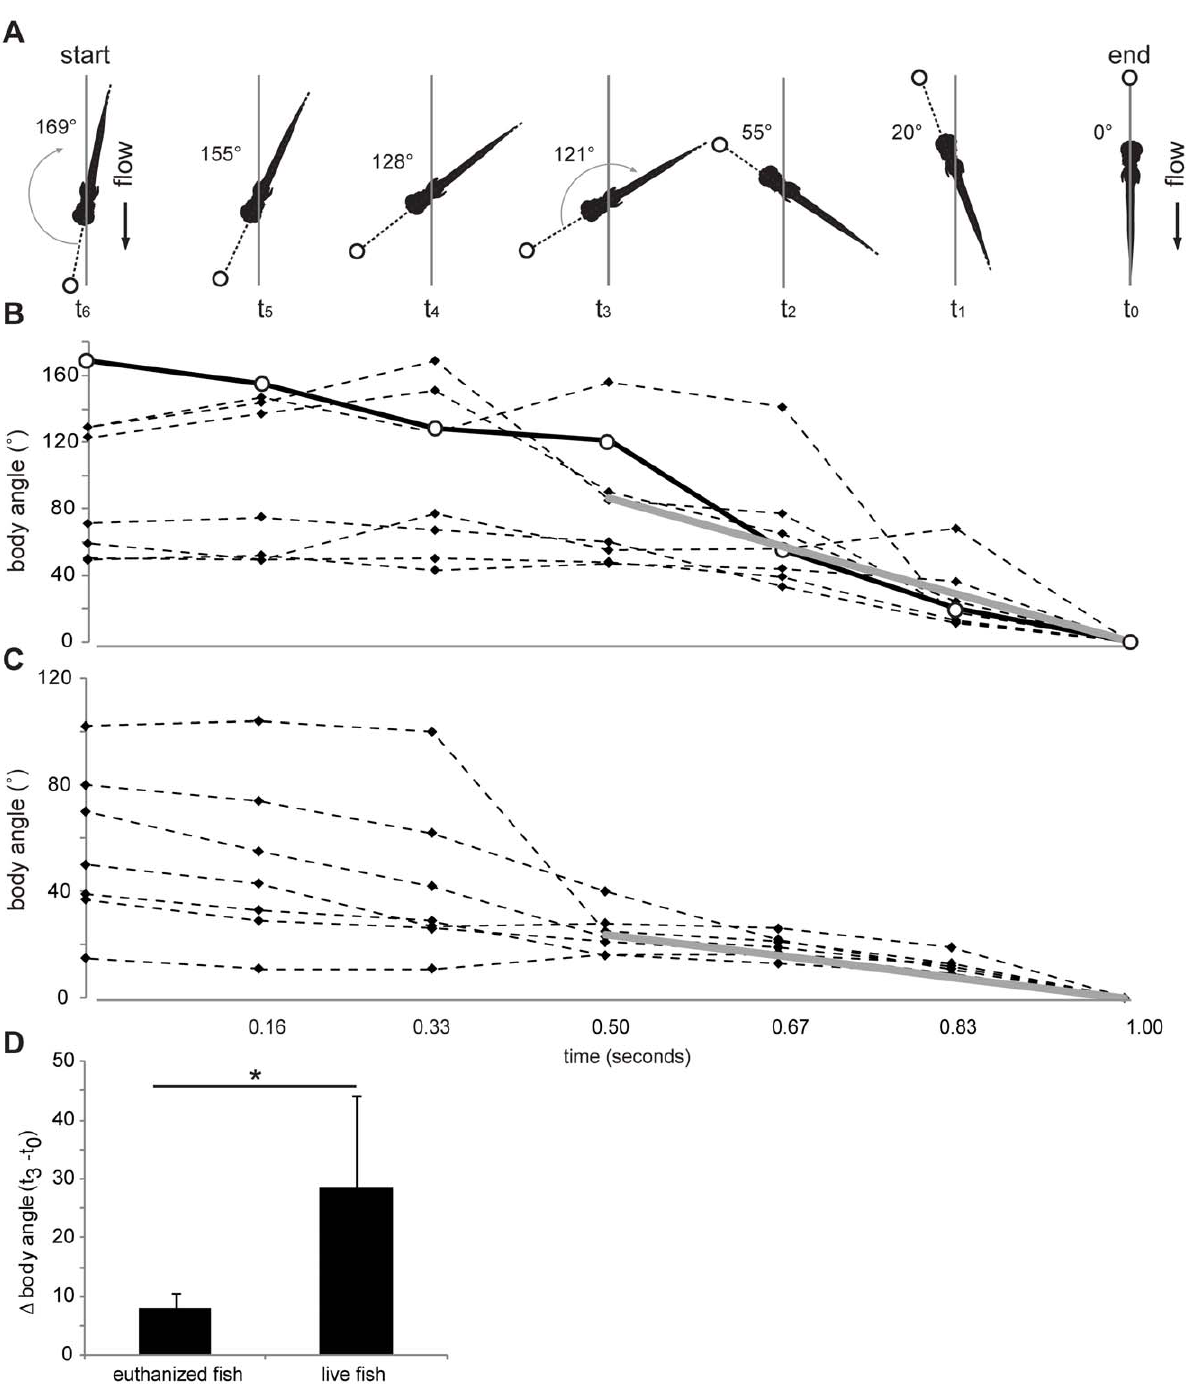
Figure 2. Larval zebrafish demonstrate rheotaxis by moving their body to orient upstream in the presence of current. A. Characteristic example of a larva turning its body upstream to align with a current created by a continuous suction source. The initial body angle relative to the flow direction (t 6 ) decreases (gray arrows) with time such that at the end of a one second video sequence the body is aligned parallel to, and facing away from, the flow (t 0 ). B. All body angles decreased over time in the presence of a current, indicating a robust rheotactic response in freely swimming larvae with an intact lateral line (n=8 larvae). The data for larva in A are highlighted by white circles and joined by a solid black line. The solid gray line for the last three data points (highlighted in the black box) represents the average change in body axis between t 3 and t 0 . C. Euthanized, and therefore passively drifting, larvae show a tendency to slowly self-orient to the current (n=7 larvae). The solid gray line represents the average rate of change in body angle between t 3 and t 0 . D. Comparison of the change in body angle between timepoints t 3 and t 0 , when fish responded robustly to the flow. Live fish turn faster to align themselves with the flow than what is expected for a passively drifting fish (Student’s unpaired, one-tailed T-test, * p , 0.01, 7 # N # 8).